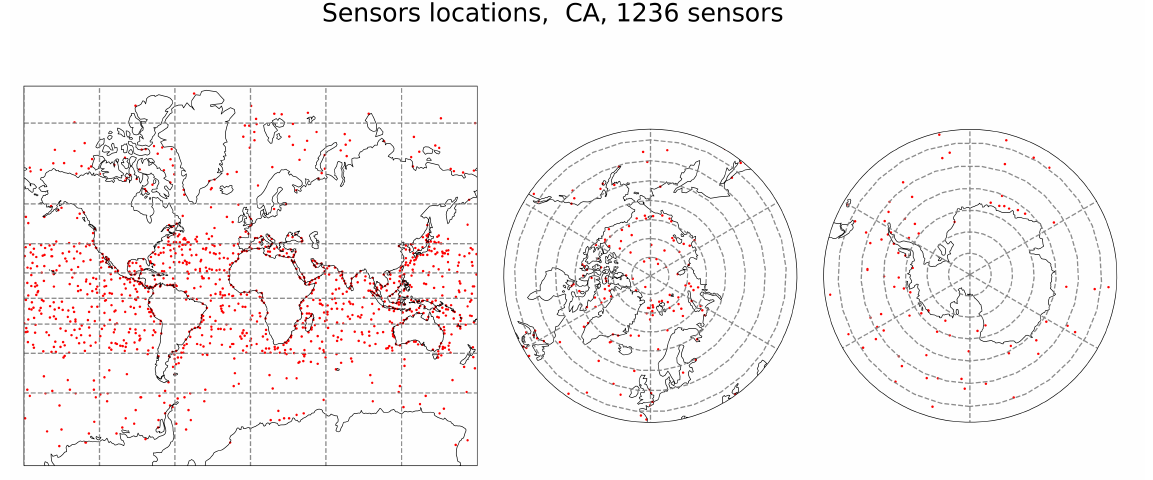
Figure 5. Locations of 1236 sensors from the Concrete Autoencoder (CA) checkpoint at epoch 508.